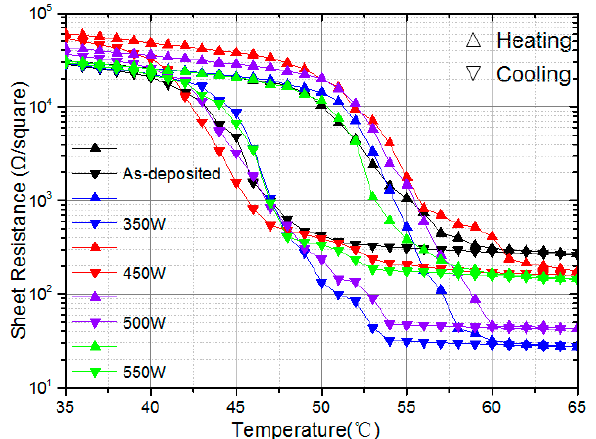
Figure 4. Temperature dependence of sheet ‐ resistance in VO 2 films treated with different Ar/O plasma powers.